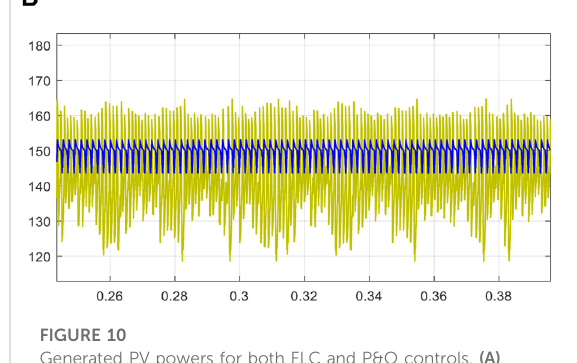
FIGURE 10 Generated PV powers for both FLC and P&O controls. (A) Power response. (B) Zoom on power response.